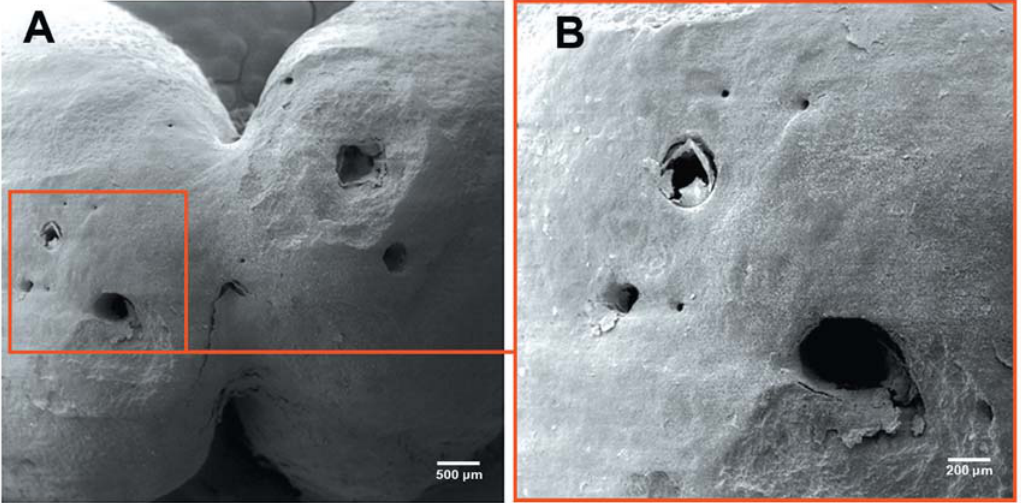
FIGURE 2- Moderate club shape hypercementosis. (A) Mesial and distal roots of a mandibular molar. (B) Greater magnification of the apical foramen and foramina. Irregular root resorption areas are observed close to the apical foramen and foramina. Original magnifications: (A) ×20, (B) ×50